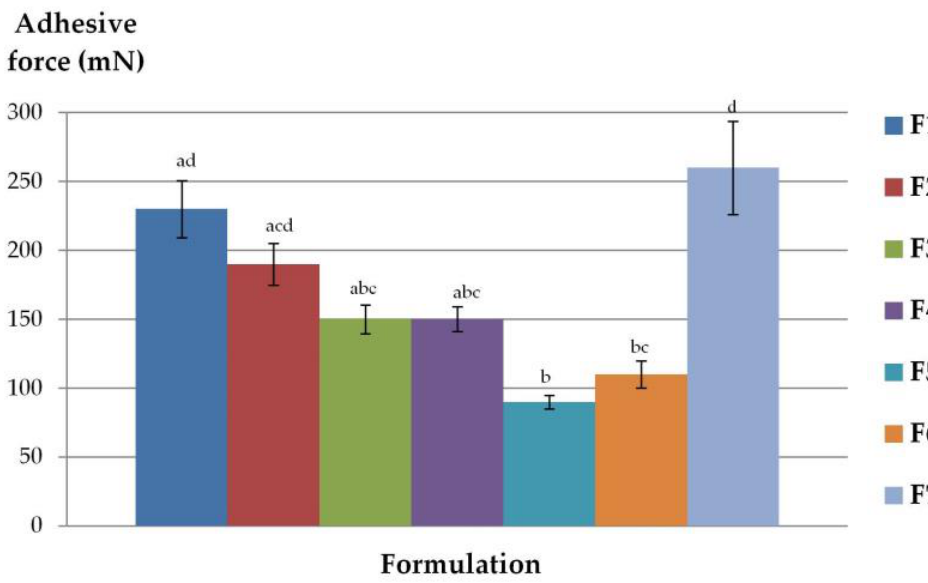
Figure 4. Adhesive force of gel formulations determined using mouse skin (mean ± S.D., n = 6). different letters ( a – d ) represent the significant differences ( p < 0.05). Table 5. Adhesive work of formulations determined using hairless mouse skin (mean ± S.D., n = 6).